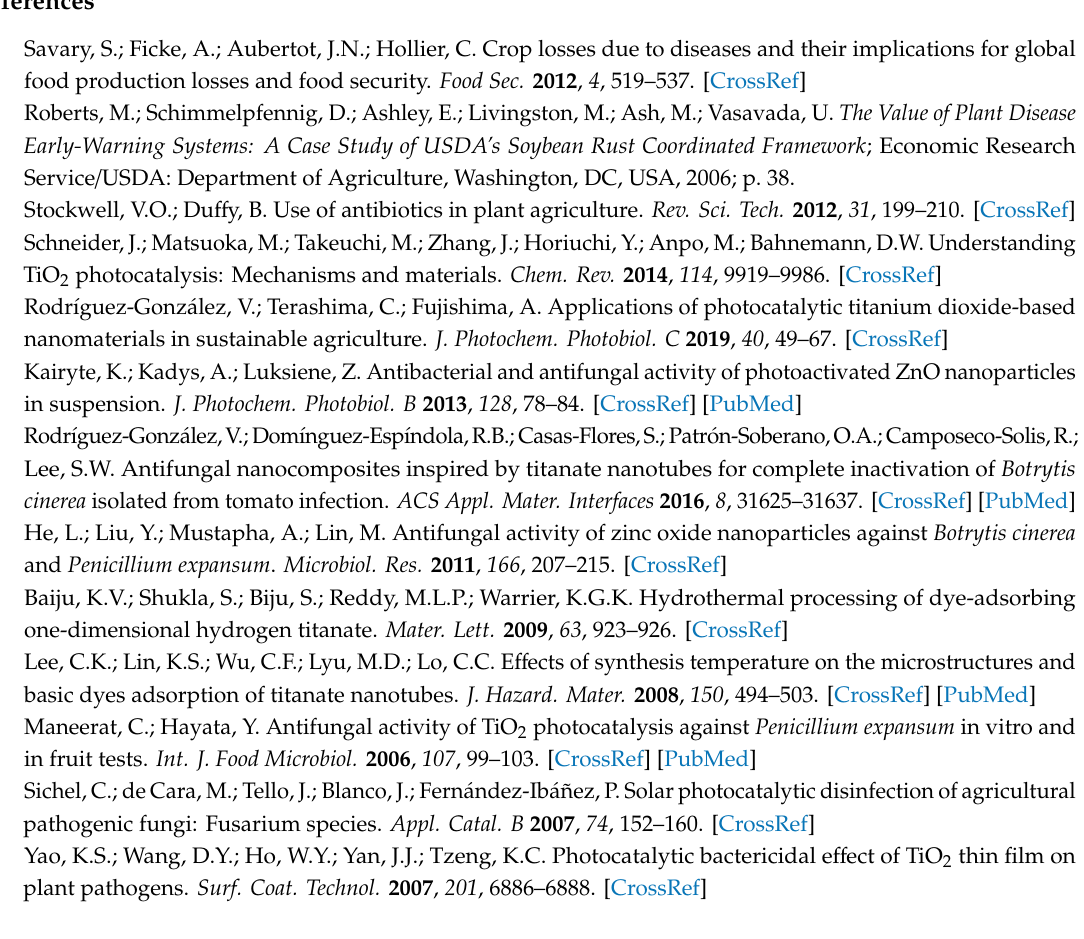
Figure S1: UV-Vis spectrum of the light source used for the